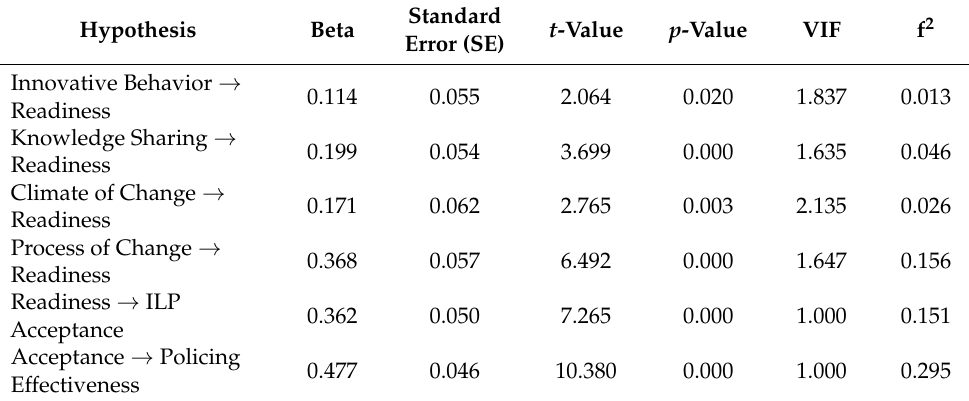
Table 3. Results of Hypothesis